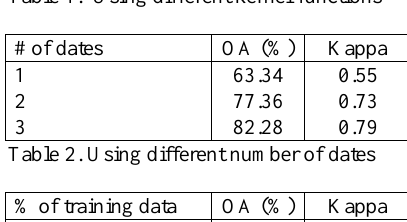
Figure 3. color composite of coherency matrix (RGB: T 11 , T 22 , T 33 ), acquired on 2012/07/17